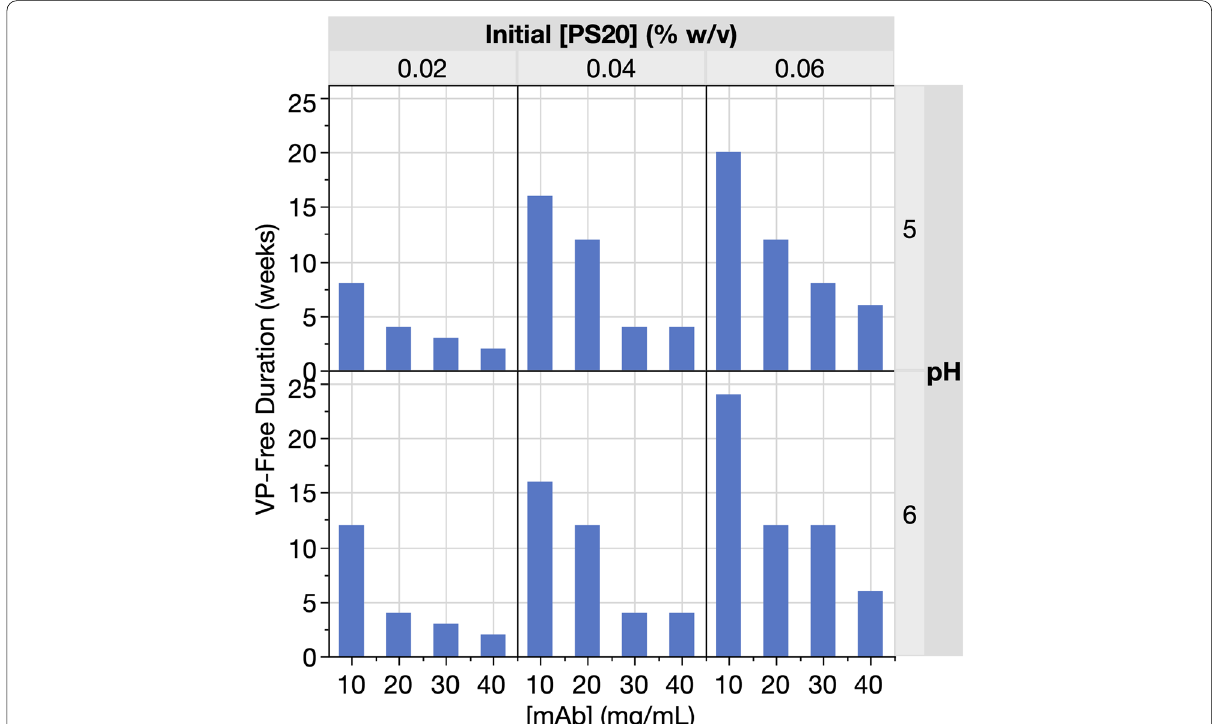
Fig. 2 Storage duration without VPs observed for mAb X DP as a function of [mAb]. The 24 formulations (listed in Table 1) represent unique combinations of [mAb], initial [PS20], and pH. At the end of the DP stability study (24 weeks at 5 °C), only one formulation (F24 as shown in Table 1) remained free from